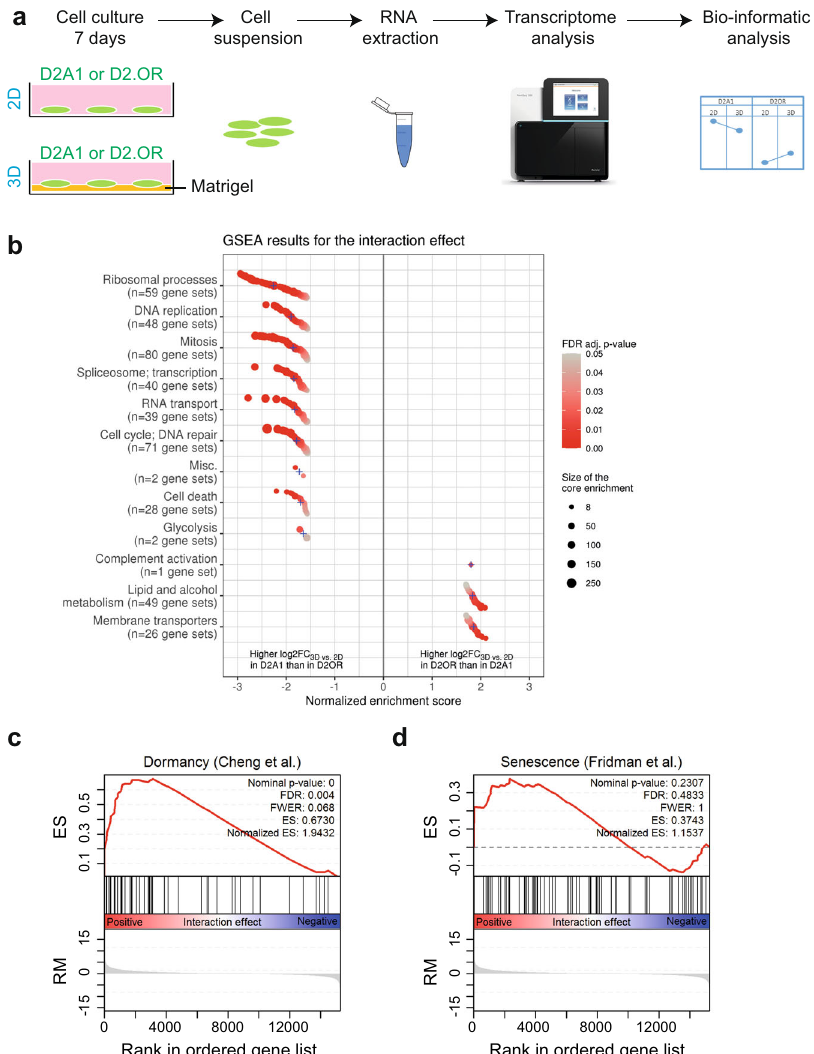
Fig. 3 Unbiased transcriptomic analysis suggests a D2.OR dormant cell cycle arrest. a Schematic representation of the experimental pipeline. b GSEA analysis on the interaction effect when comparing D2A1 and D2.OR in 2D and 3D. Positive normalized enrichment score (NES) indicates that gene sets that were log2-fold change (log2FC) 3D vs. 2D in D2.OR cell line are higher than the log2FC(3D – 2D) in D2A1. Respectively, negative NES that corresponds to gene sets was log2FC(3D – 2D) that is higher in D2A1 than in D2.OR. Gene sets ordered by normalized enrichment score (NES) within each cluster. Blue crosses represent average NES in each cluster. Point color represents FDR- adjusted p -value and size represents core enrichment. GSEA = gene-set enrichment analysis. c, d GSEA analysis of a published dormancy signature (Cheng et al. 53 ) ( c ) or senescence signature (Fridman et al. 54 ) ( d ) on the interaction effect when comparing D2A1 and D2.OR in 2D and 3D. ES enrichment score, RM ranking